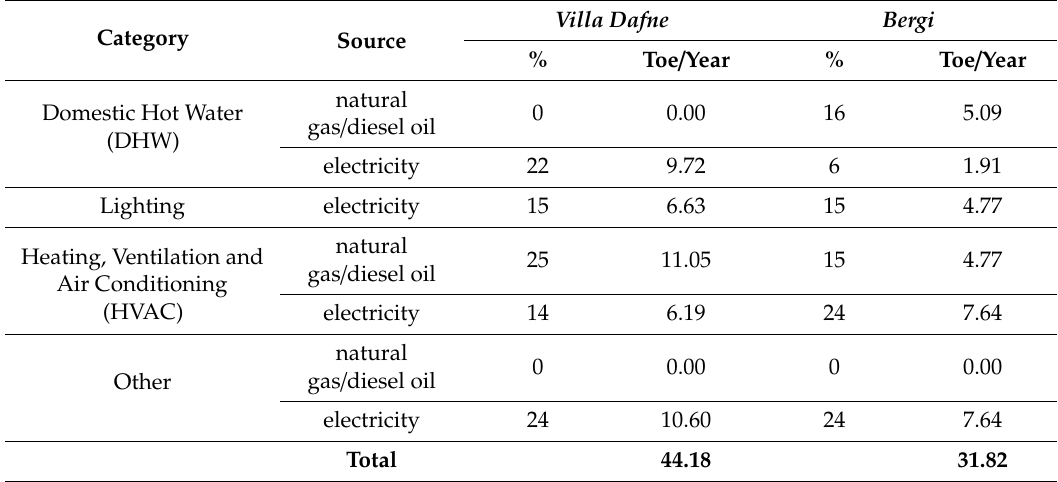
Table 3. Energy sources and energy consumption breakdown for the two selected